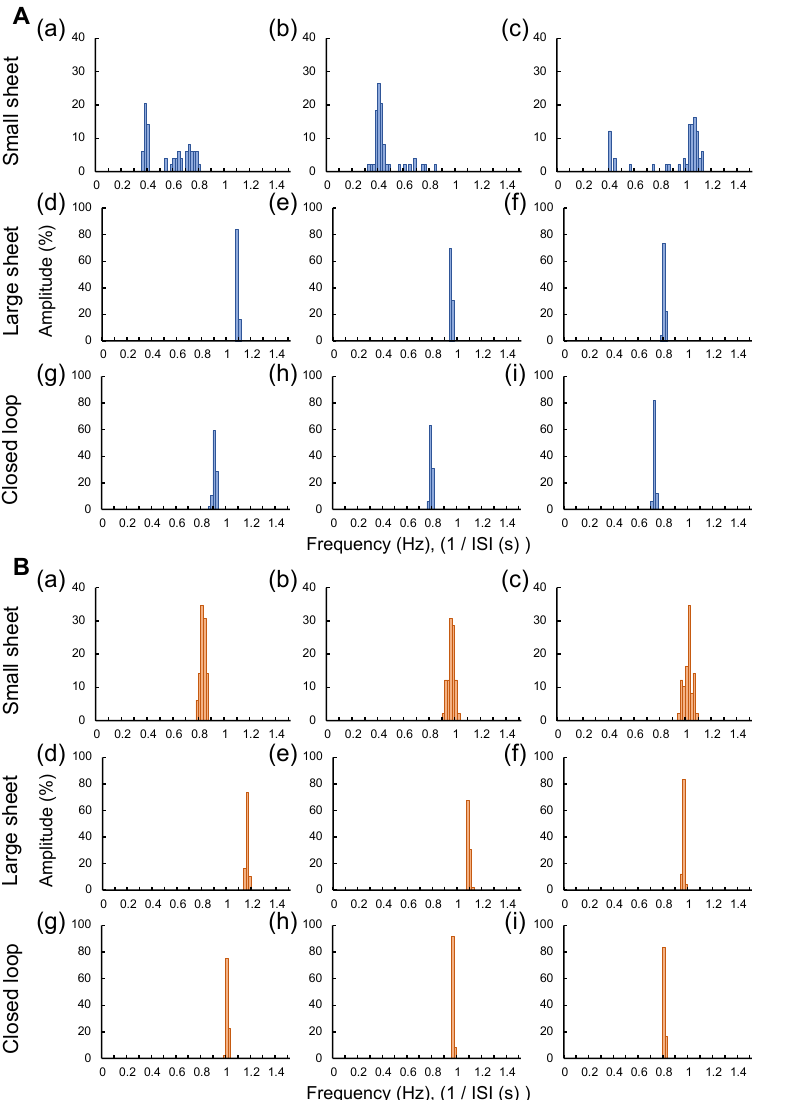
Figure 5. The beating frequency distribution of three type cardiomyocyte network samples at Control and Medium states. ( A ): The distribution of beating frequency (1/ISI, Hz) of three samples in Control state: ( a – c ) small sheet group, ( d – f ) large sheet group, and ( g – i ) closed-loop group. ( B ): The distribution of beating frequency in Medium state: ( a – i ) were the same cardiomyocyte network samples as shown in A ( a – i